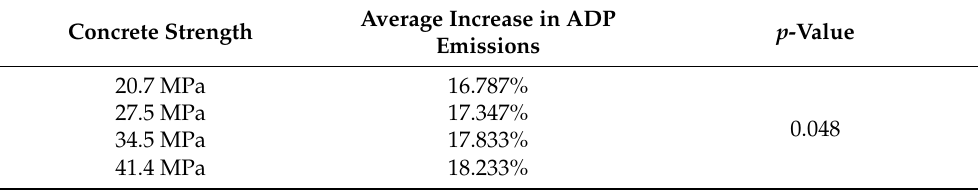
Table 14. ADP p -value for concrete strength and average increase in emissions with increasing CS. Table 15. HTP p -value for concrete strength and average increase in emissions with increasing